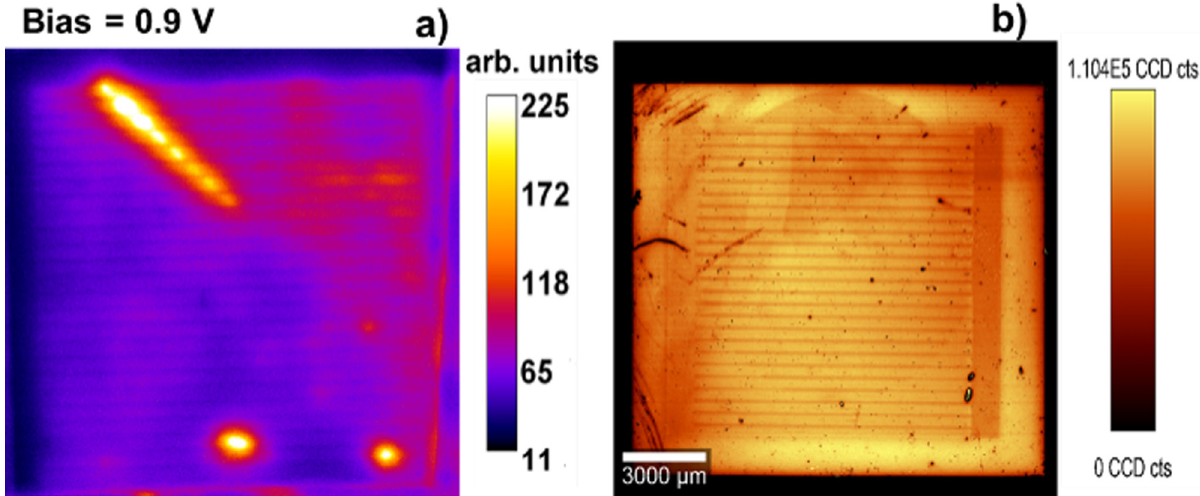
Fig. 5. (a) EL image of Si-IBC-2 at 0.9 V bias compared to PL image (b) obtained by m -confocal